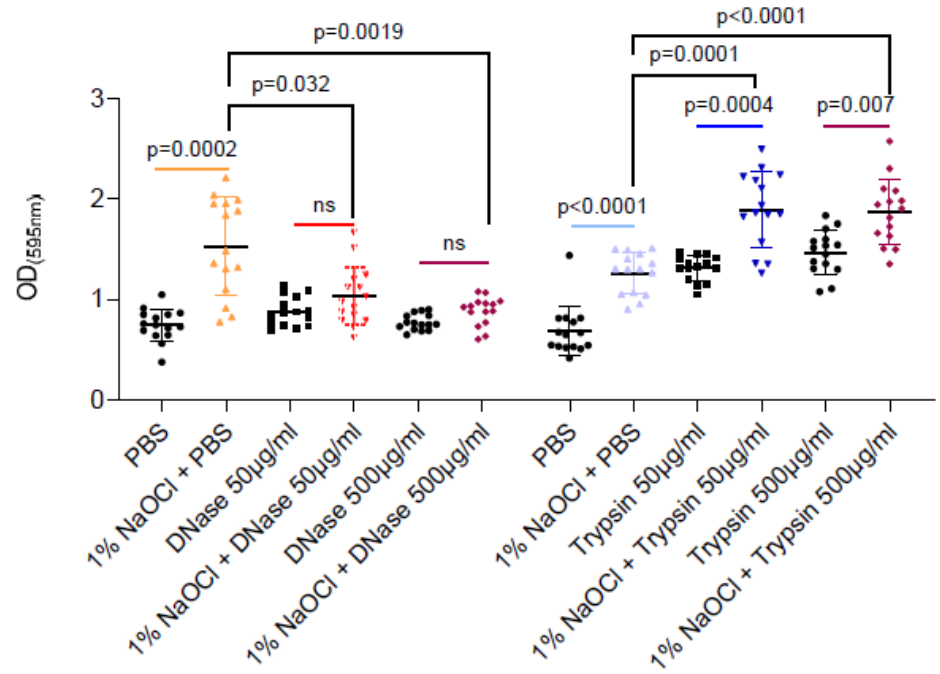
Figure 2. DNase but not trypsin treatment efficiently reduced the remaining biofilm biomass- treat- ments are indicated in the vertical axis’ legend. E. faecalis cells were diluted 1:100 into a TSB fresh medium. 100 µ L of cultures were split into a 96-well polystyrene plate and further incubated at 37 ◦ C for 24 h. Biofilm was untreated or treated with different concentrations of NaOCl (1%, 3% or 5%) for 5 min. Biofilm cells were washed with PBS, and 100 µ L of PBS/DNase/Trypsin in the indicated concentrations were added to each well and further incubated at 37 ◦ C for 24 h. Biofilm biomass was assessed by crystal violet staining. Graphs represent the mean ± SD from five biological repeats ( n = 25). Statistical analysis was performed using Brown–Forsthye and Welch’s ANOVA with Dunnett’s T3 multiple comparisons test. p < 0.05 was considered statistically significant.